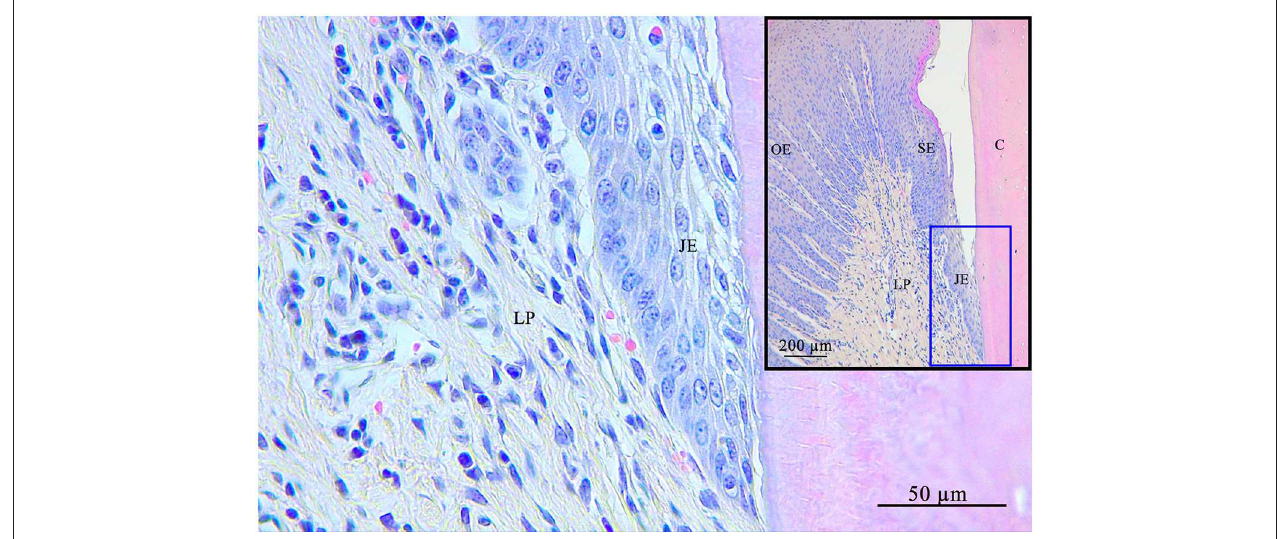
FIGURE 4 | Junctional epithelium (blue square) at the bottom of the gingival sulcus. The junctional epithelium is the connection of the gingiva with the tooth. C, cementum; JE, junctional epithelium; SE, sulcular epithelium; OE, oral epithelium; LP, lamina propria.